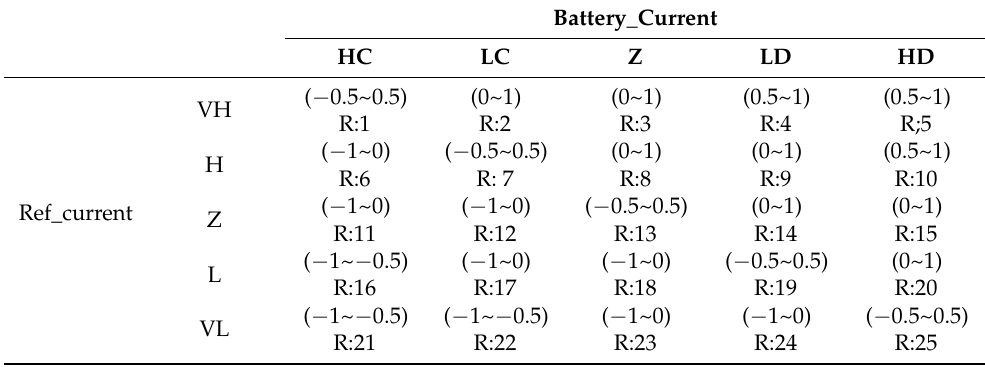
Table 8. Fuzzy rules (R) for